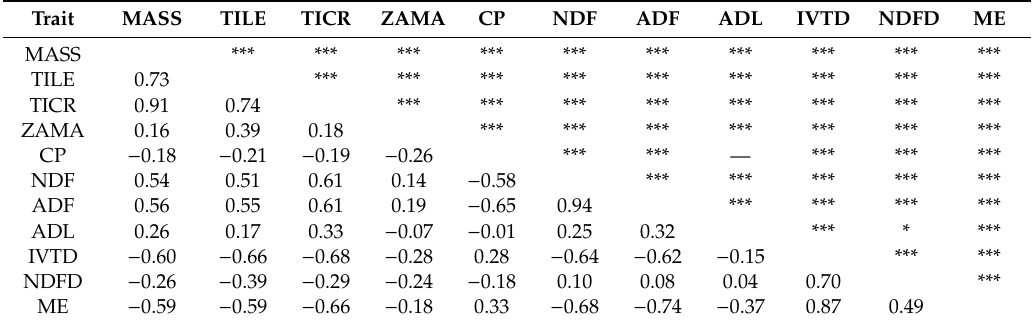
Table 2. Pearson Correlation Coe ffi cient of the 192 full-sib progeny (genets) of the M26 × M35 intermediate wheatgrass mapping population evaluated over two years at Logan, UT, USA in three clonally replicated competition